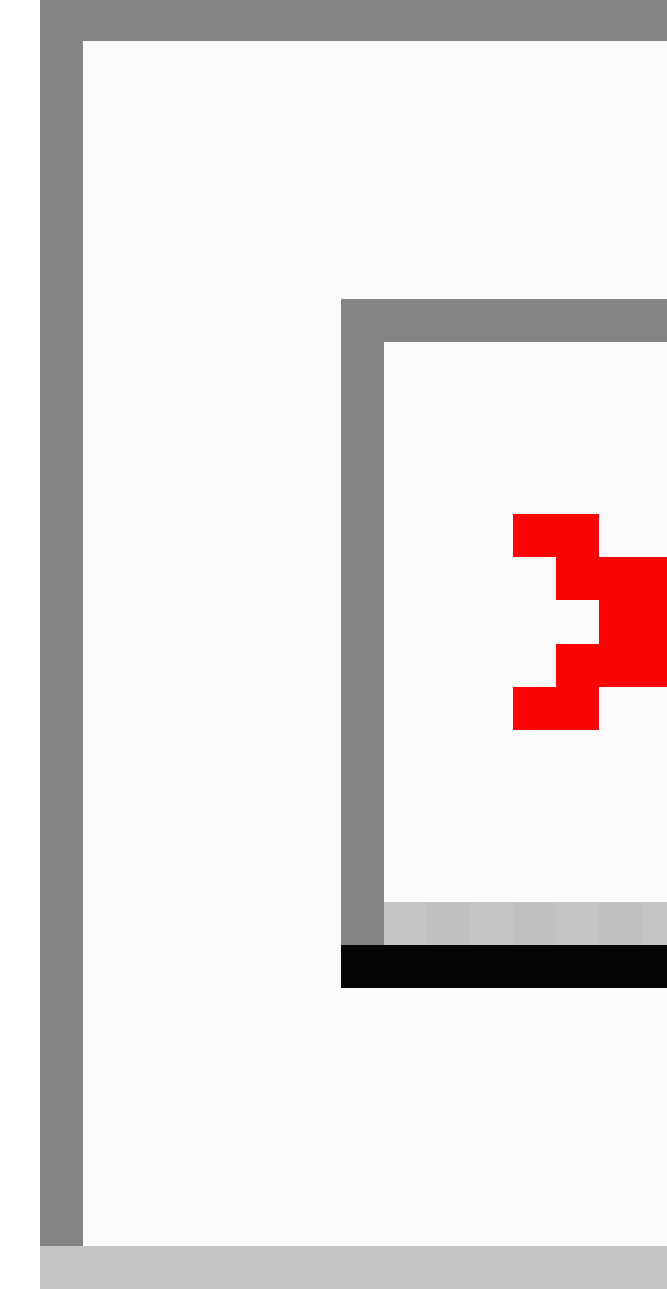
Figure 6. Example of drill down path to more detailed